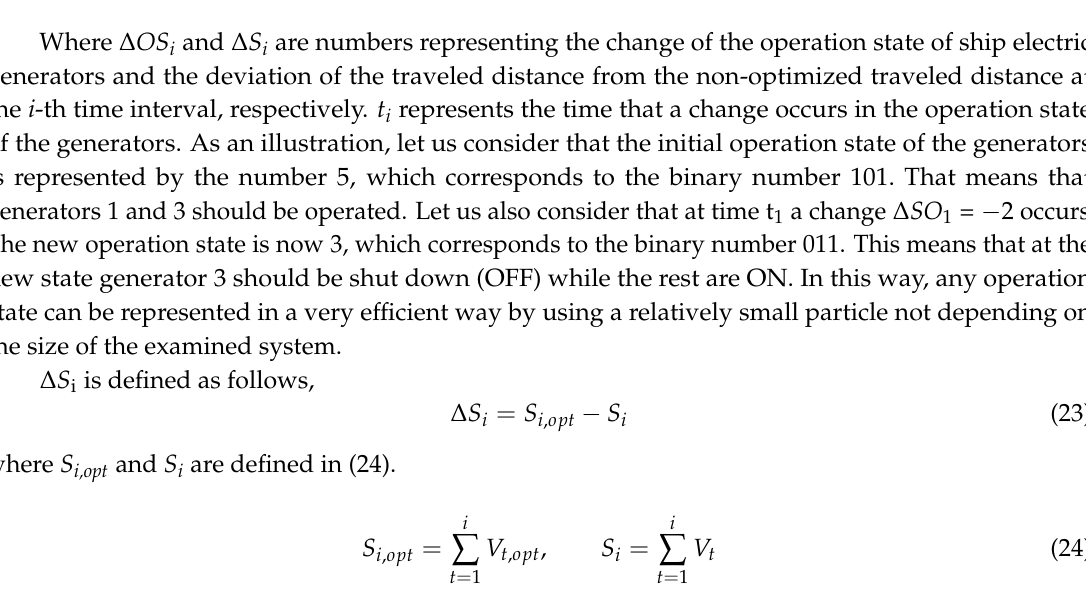
Figure 2. Particle structure.